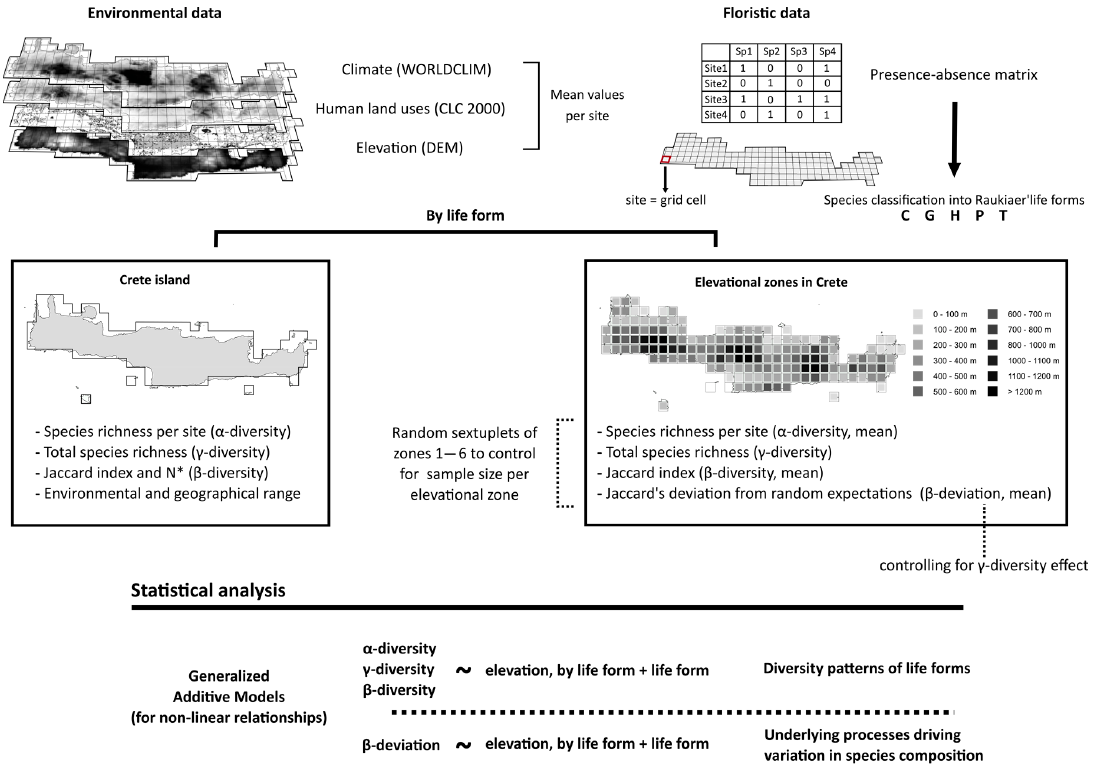
Figure 1. Illustration diagram of the statistical analysis we performed to explore the diversity patterns of different life forms. Life form abbreviations: C = chamaephytes, G = geophytes, H = hemicryptophytes, P = phanerophytes, T = therophytes. Other abbreviations: CLC2000 = CORINE Land Cover 2000 database, DEM = Digital Elevation Model